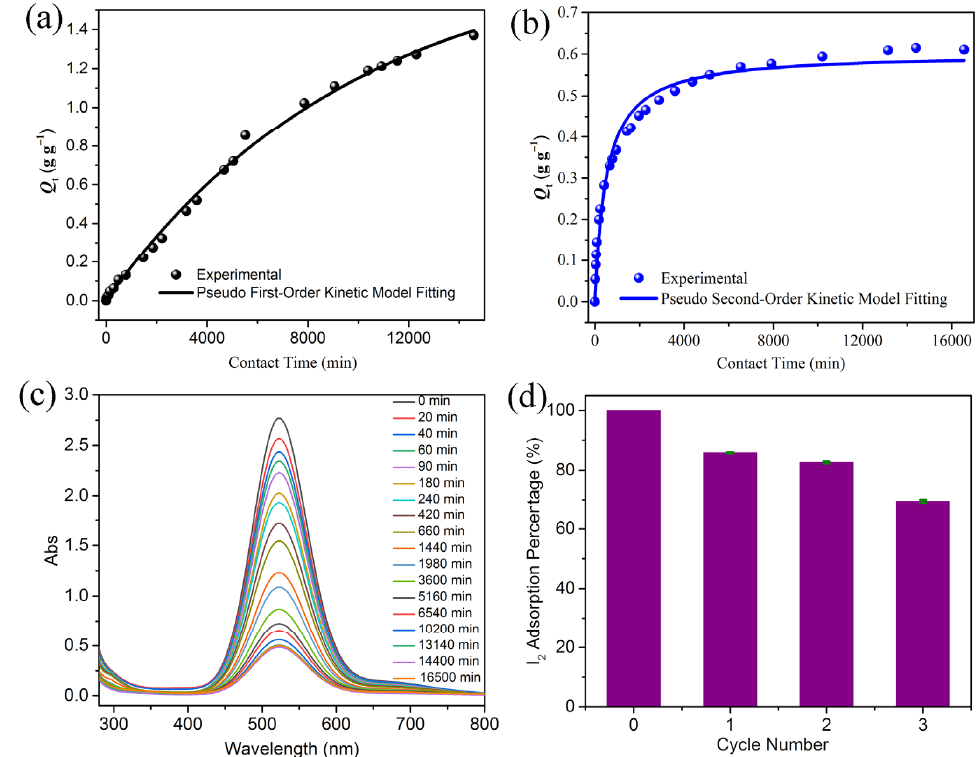
Figure 3. ( a ) Time ‐ dependent iodine vapor uptake plot for the crystals of compound 1 at room temperature. ( b ) Time ‐ dependent dissolved iodine uptake plot for the crystals of compound 1 at room temperature. ( c ) Time ‐ dependent UV ‒ Vis spectrum evolution of the solution of I 2 in cyclohexane with the crystals of compound 1 as adsorbent. ( d ) Graph showing the recyclability of compound 1 for dissolved iodine adsorption.